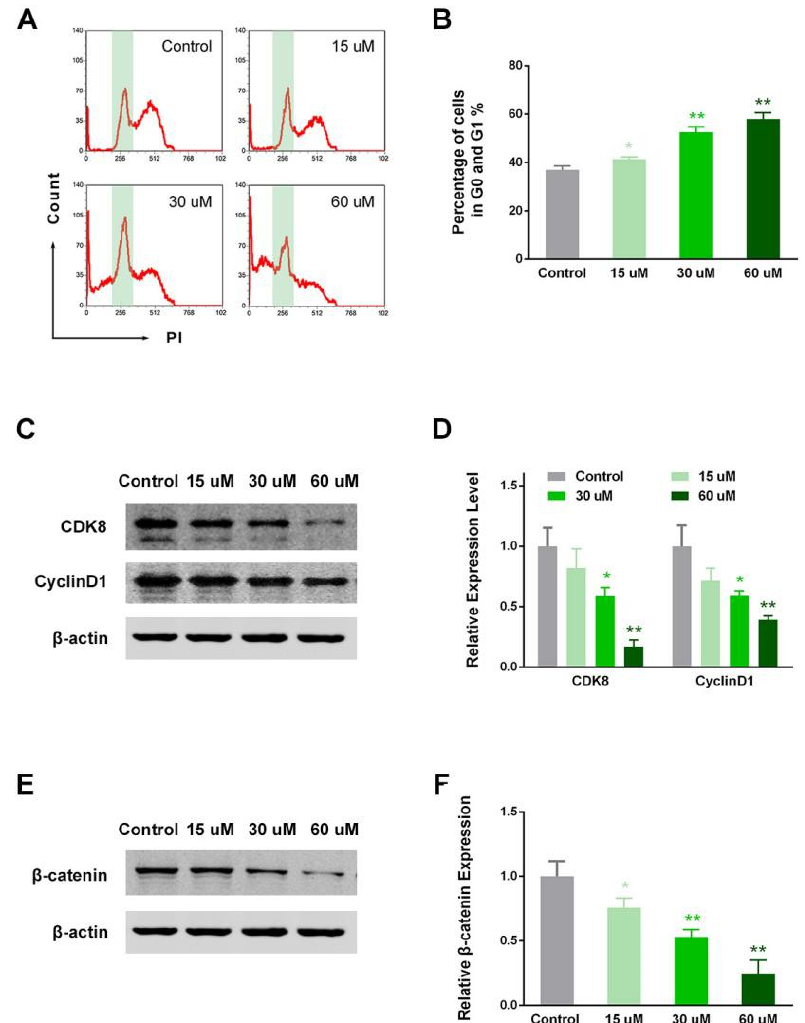
Figure 5. EP modulated RCC cell cycle and suppressed β -catenin expression. ( A ) Typical samples of flow cytometry analysis for cells in different phases, after 48 h of treatment. ( B ) EP groups displayed a dose-dependent increase in G0/G1 cell percentage compared with the control. ( C ) Typical blots of CDK8 and cyclin D1. ( D ) EP groups demonstrated a dose-dependent decrease in CDK8 and cyclin D1 expression. ( E ) Typical blots of β -catenin. ( F ) EP groups showed a dose-dependent decrease in β -catenin. * p < 0.05; ** p < 0.01 vs. control.